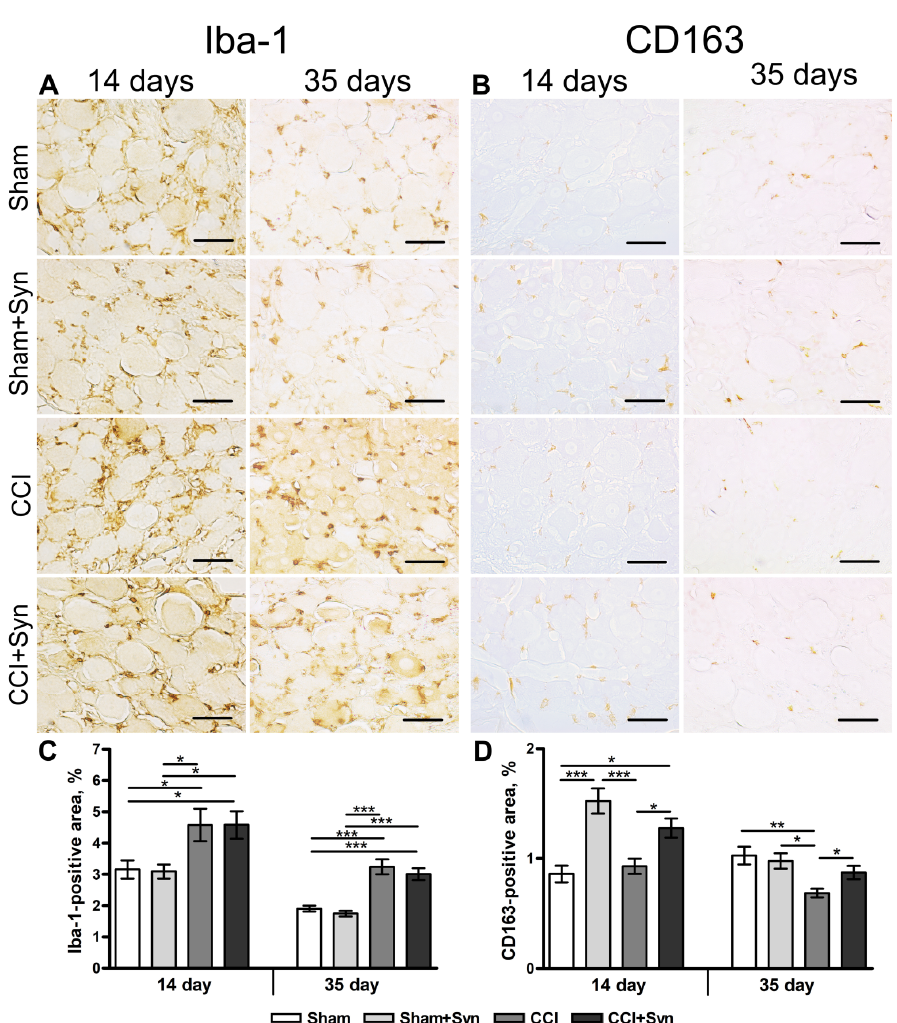
Figure 5. Inflammation in DRG after chronic constriction injury and synaptamide